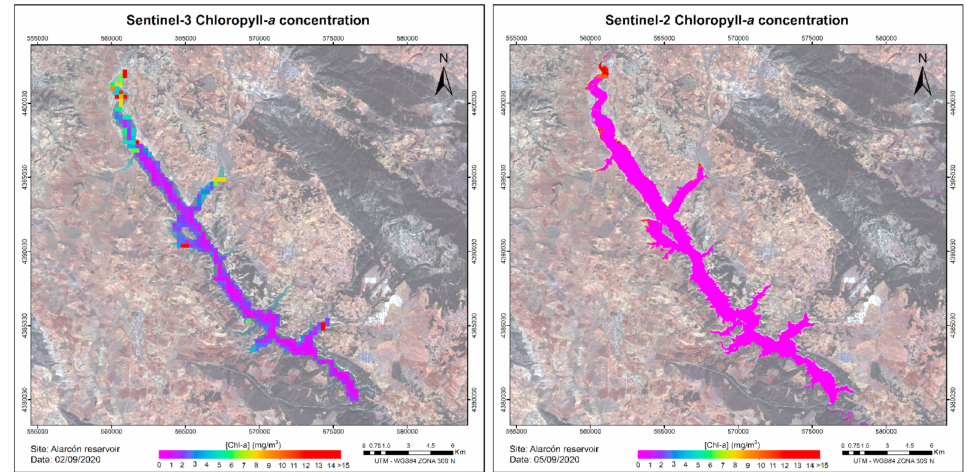
Figure A1. Thematic maps of Chl_a concentration for Alarc ó n reservoir using S3 (left) and S2 (right) images.